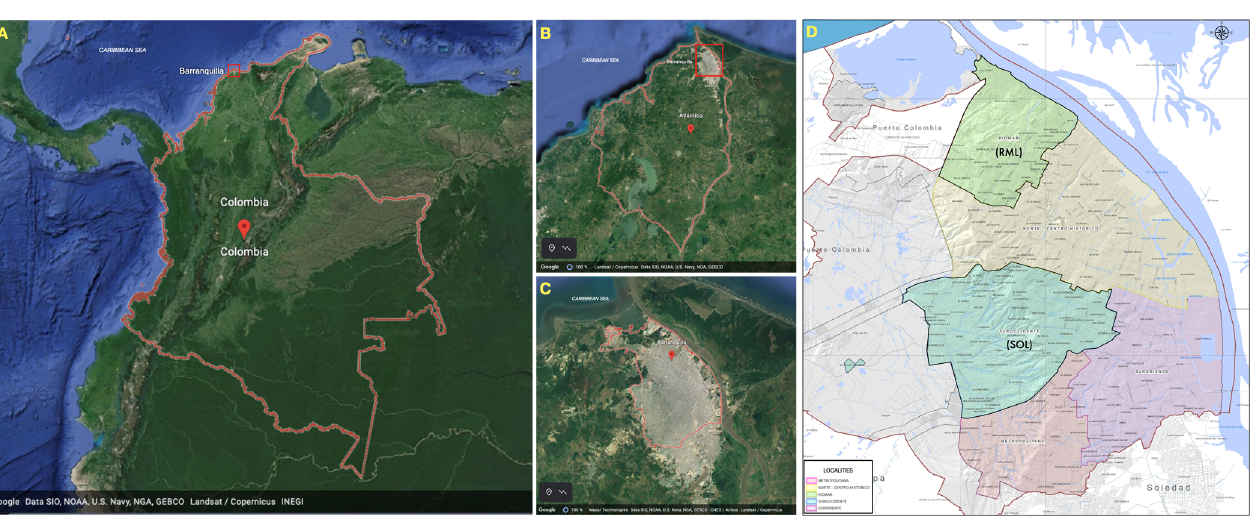
Figure 1. ( A ). Barranquilla city’s location at the Republic of Colombia; ( B ). Atlántico department and its capital Barranquilla; ( C ). Barranquilla city. Scheme 2021, accessed on 25 August 2021. ( D ). Riomar (RML) and Suroccidente (SOL), localities of the city of Barranquilla focused on the study. Source: adapted from Plan de Ordenamiento Territorial de Barranquilla 2012–2032.